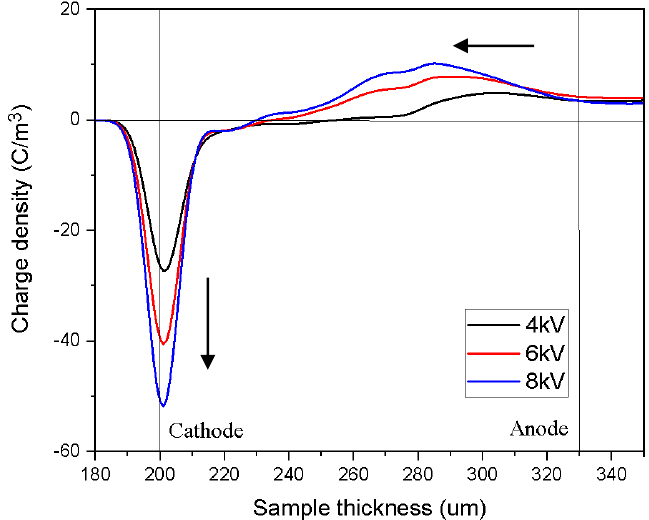
Figure 2. Space charge dynamics at different DC electric fields (volt ‐ on 30 min at 20 °C, three layers, about 130 μ m in total sample thickness).